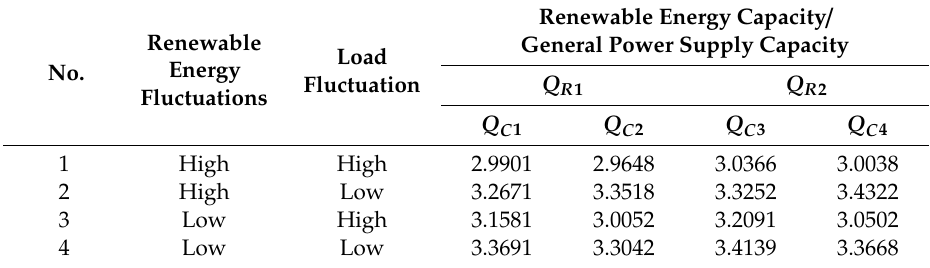
Table 8. Standardized indicators matrix for generation expansion planning decision-making.